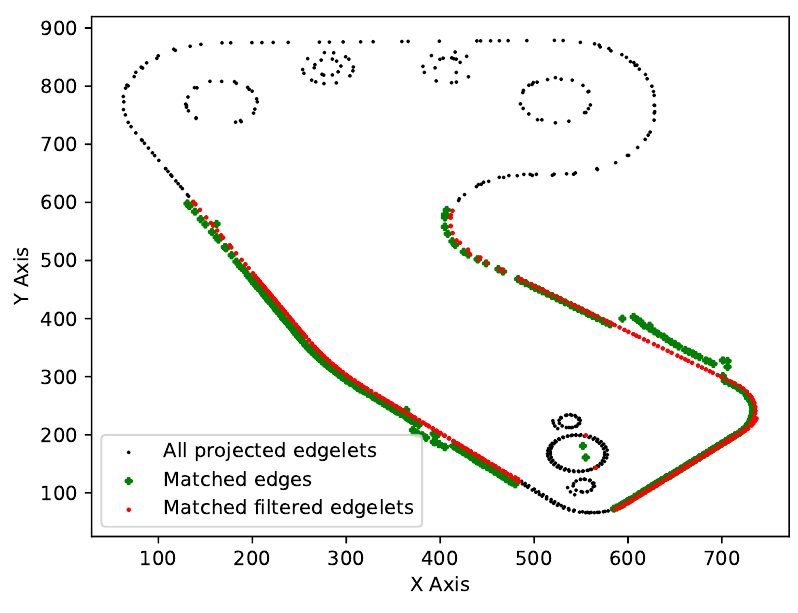
Figure 15. The shapes used in the shape context approach.